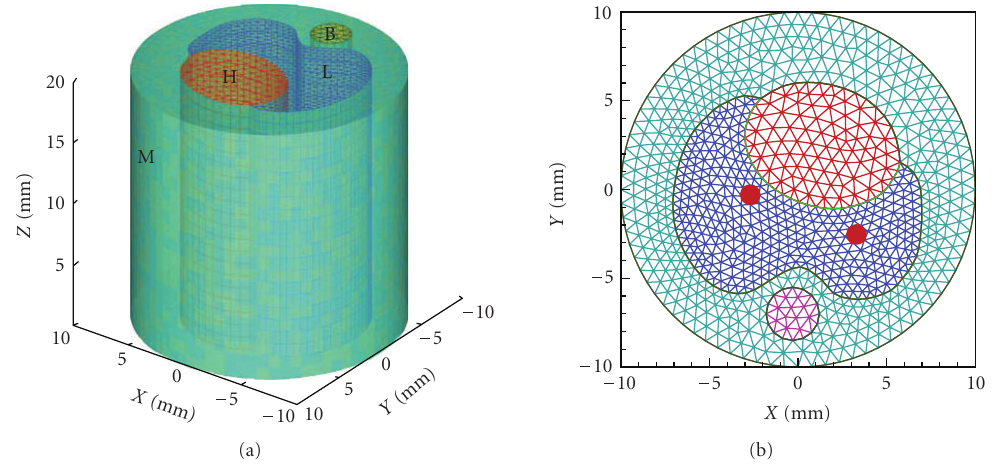
Figure 3: Heterogeneous cylindrical mouse phantom of diameter 20 mm and height 20mm. (a) The phantom containing four types of materials for muscle (M), lungs (L), heart (H), and bone (B), respectively, and (b) a transverse section of the phantom with the true source locations shown as the two red disks.